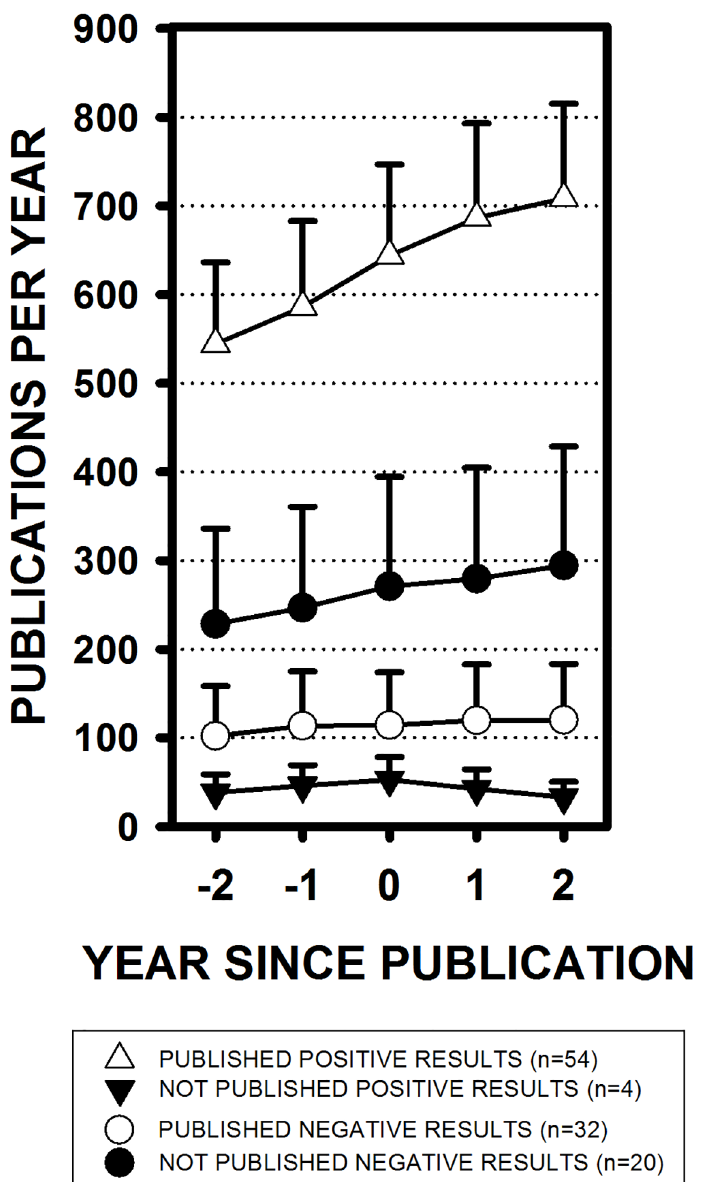
Fig 4. Research activity levels by study outcome. The number of papers published each year on the same topics as the studies included in the present analysis (means ± SEM). Publication years range from two years before (-2) until two years after the year the studies included in the present analysis were either completed or published (year 0). For example, even two years before the publication of the studies reporting positive results, on average, 544 ± 92 papers were already being published each year on those same topics. Two years before the publication of the studies reporting negative results, only 102 ± 56 papers were being published each year on those topics.